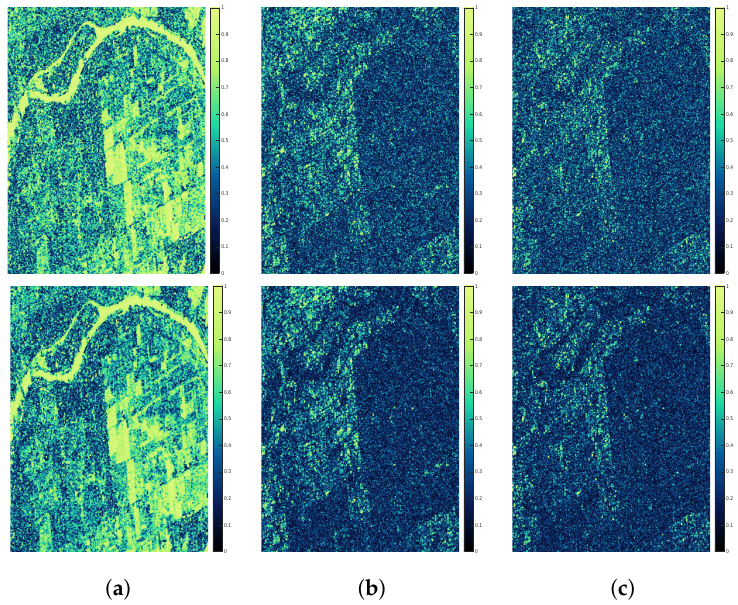
Figure 11. Polarimetric coherences for Subset 1 of Figure 8. (Top): Boxcar 5 decorrelation stage. (Bottom): Boxcar 5 ( b ) HHHV coherence; ( c ) VVHV